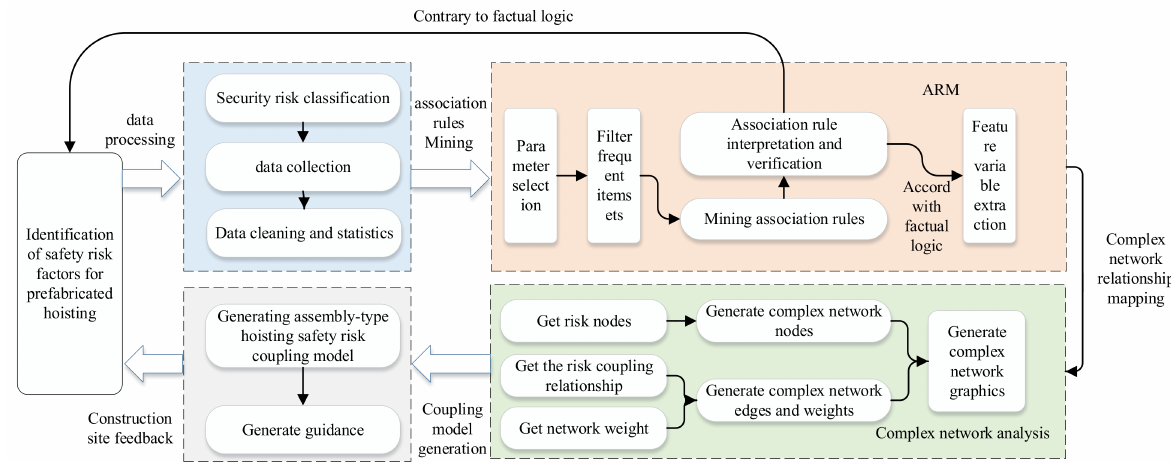
Figure 6. The process of establishing the safety risk coupling model of the prefabricated building